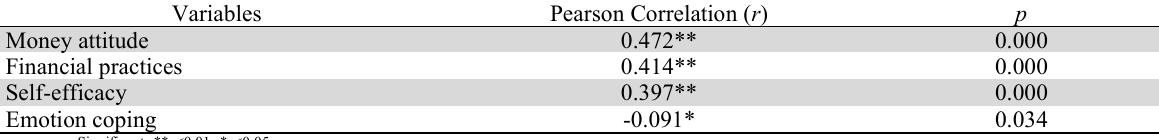
Pearson’s Correlation Coefficients between money attitude, financial practices, self-efficacy, and emotion coping with FWB Variables Pearson Correlation ( r ) p Money